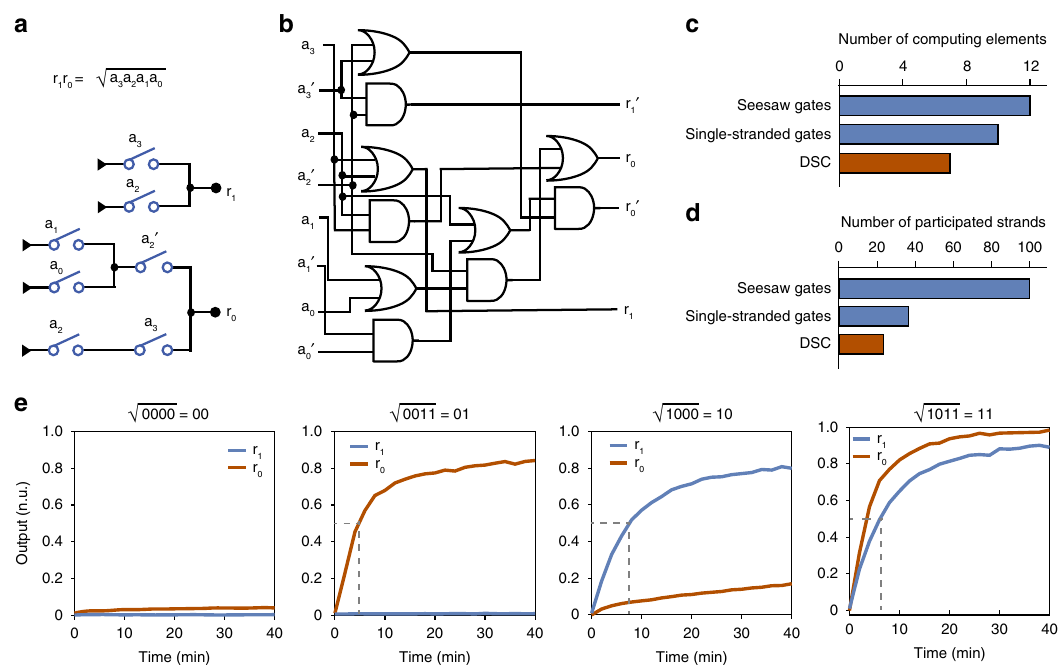
Fig. 6 A DSC for square-root calculation. a The DSC used to calculate the square root of a four-bit number. b A dual-rail logic circuit to perform the same square-rooting function. c Number of computing elements using DSC in comparison with previous logic gate circuits with seesaw gates 13 and single- stranded gates 34 . d Number of participated DNA strands using DSC in comparison with previous logic gates implementations. e Experimental computing kinetics with four representative inputs. Source data are provided as a Source Data fi